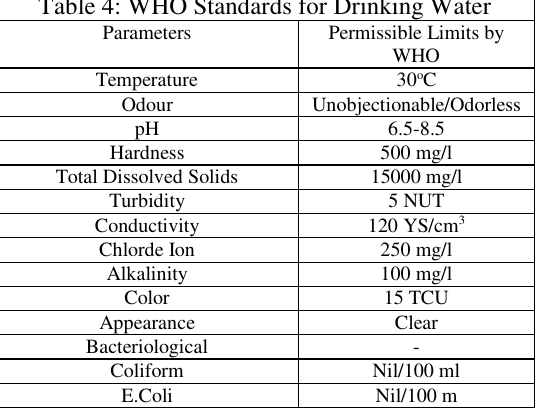
Table 4: WHO Standards for Drinking Water Parameters Permissible Limits by